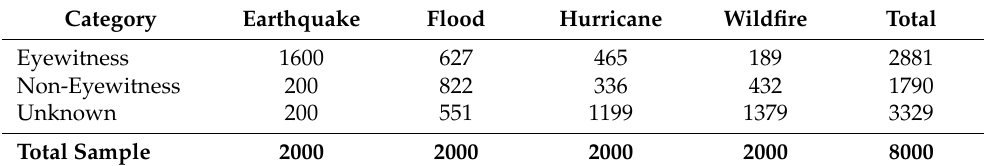
Table 4. Statistics of Evaluation